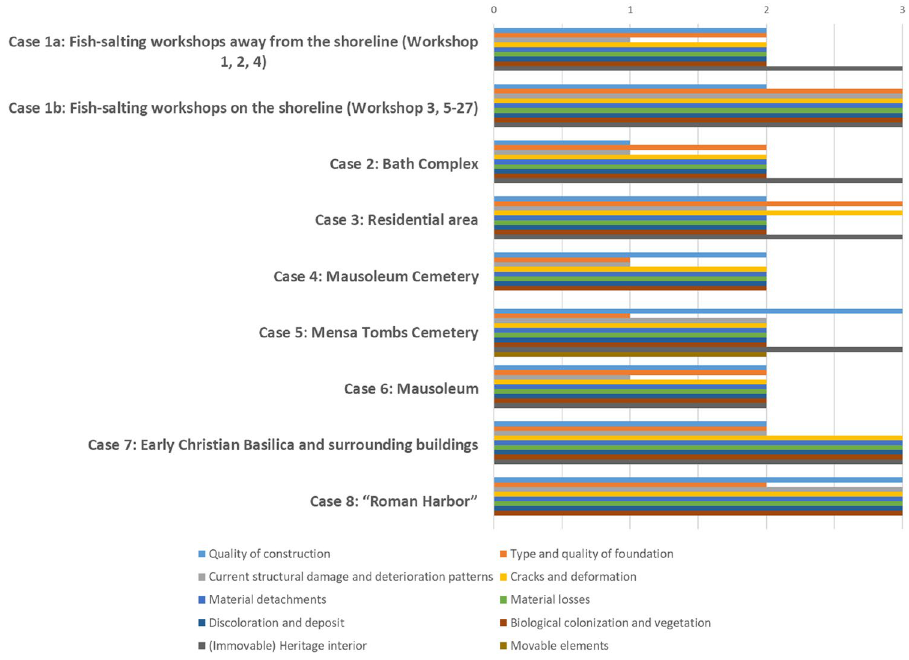
Fig. 3 Analysis of the suscepti- bility indicators in